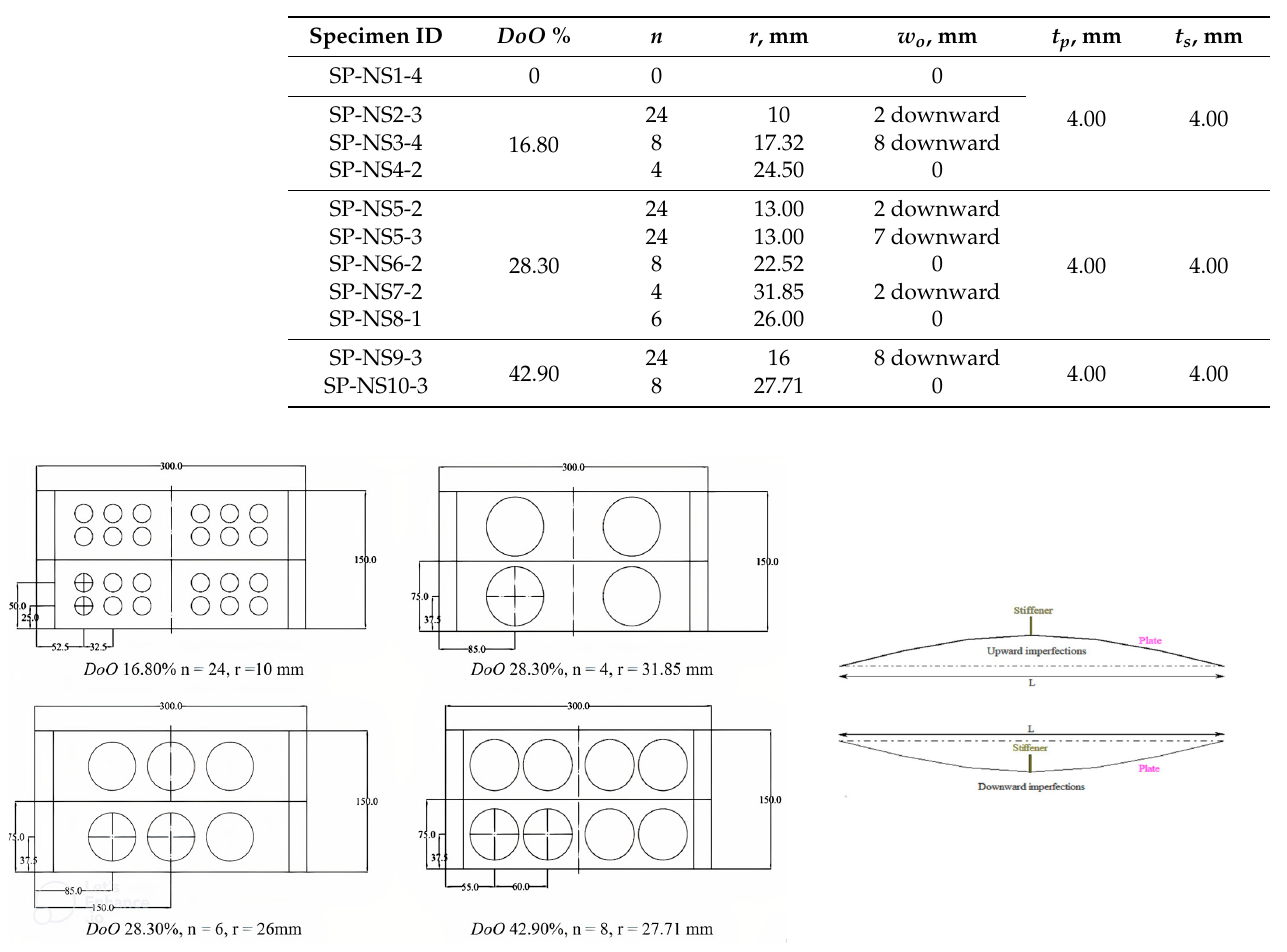
Table 1. Structural configurations of perforated stiffened plates.